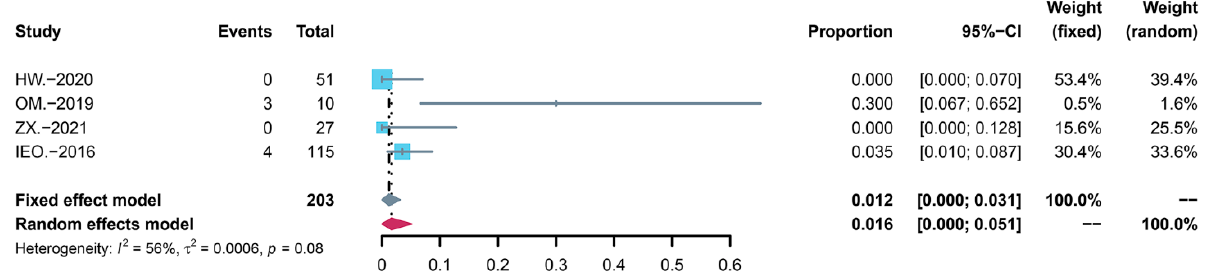
Figure 3. Forest map of serious adverse events after removal of the biased data.